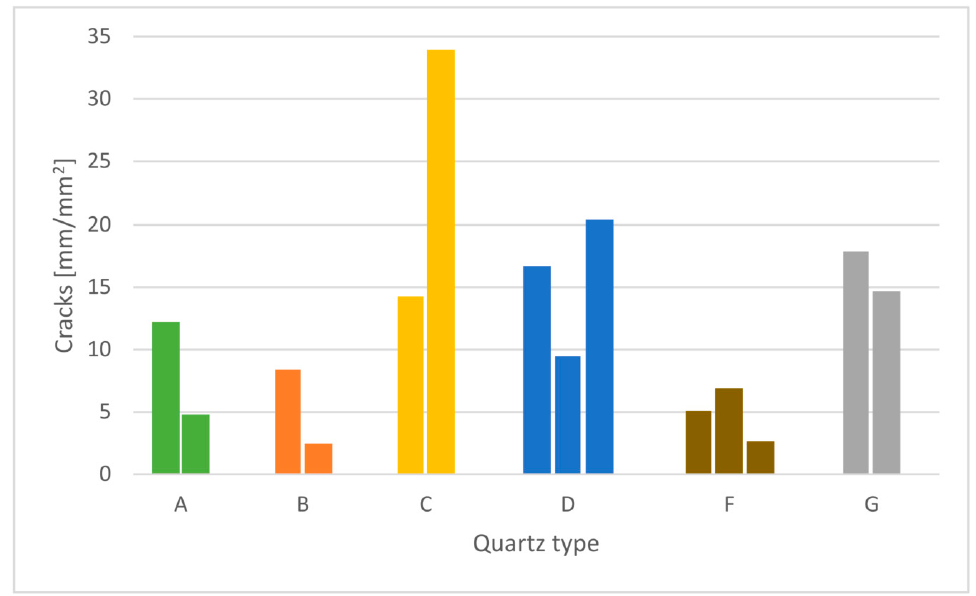
Figure 4. Summary of the crack formation for all the quartz types. The amount of cracks is given in mm/mm 2 .